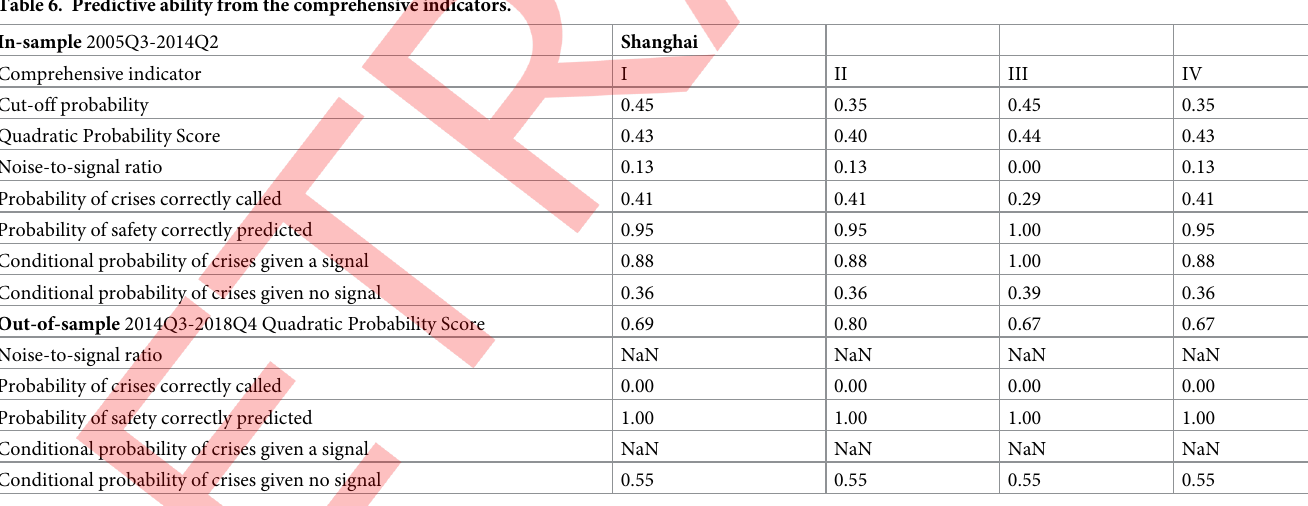
Table 6. Predictive ability from the comprehensive